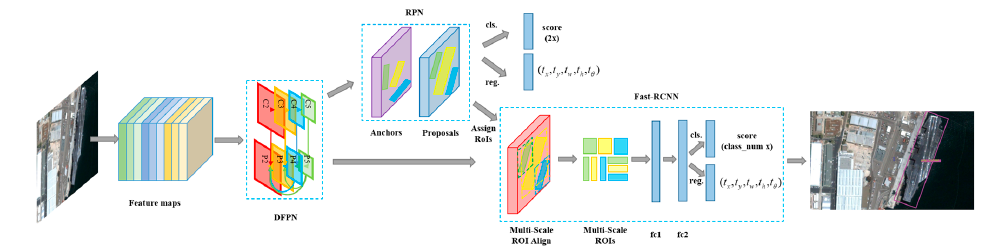
Figure 2. Overall framework of Rotation Dense Feature Pyramid Networks (R-DFPN).